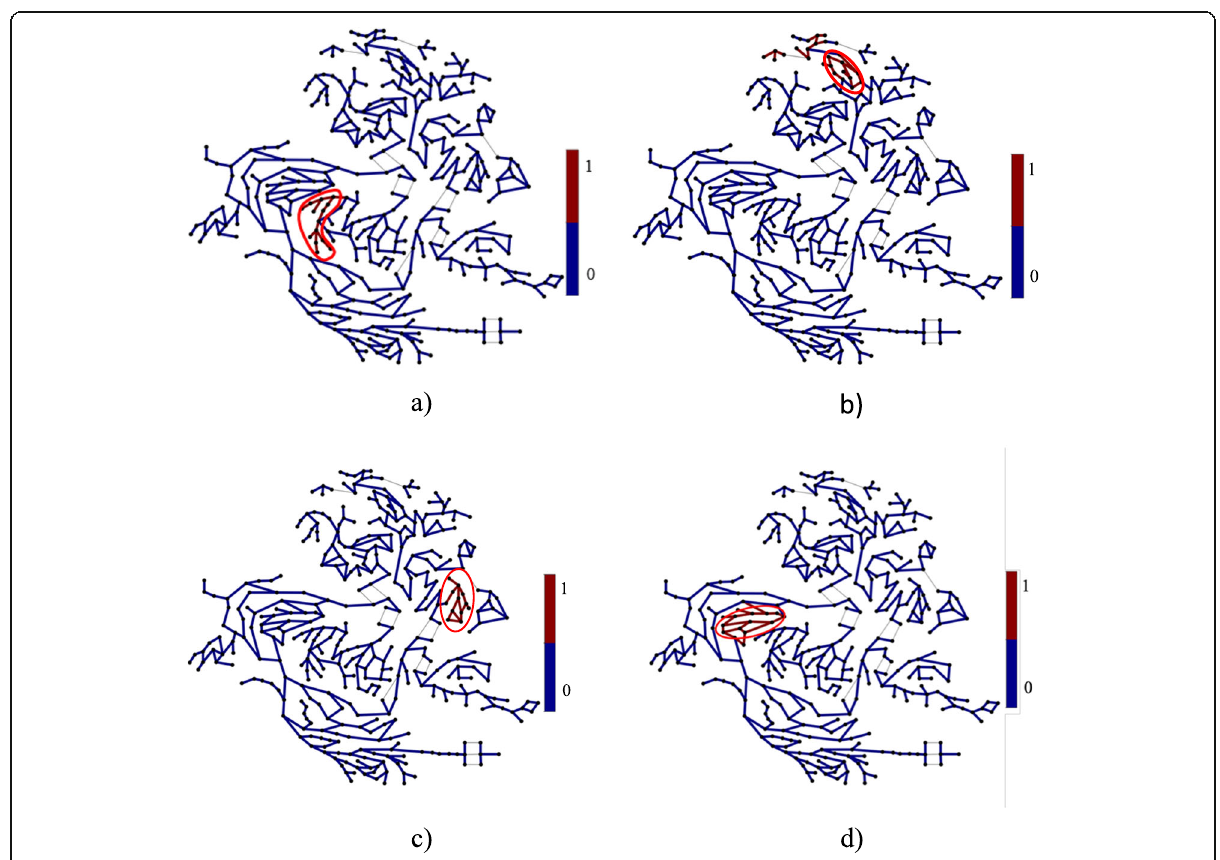
Fig. 20 The probability of leak alert by AE detection model incorporating multiple attempts strategies for leak happens on pipe in the WSN: a Monitoring sensors located in DMA 4, c Monitoring sensors located located in DMA 2, c Monitoring sensors located in DMA 3, d Monitoring sensors located in DMA